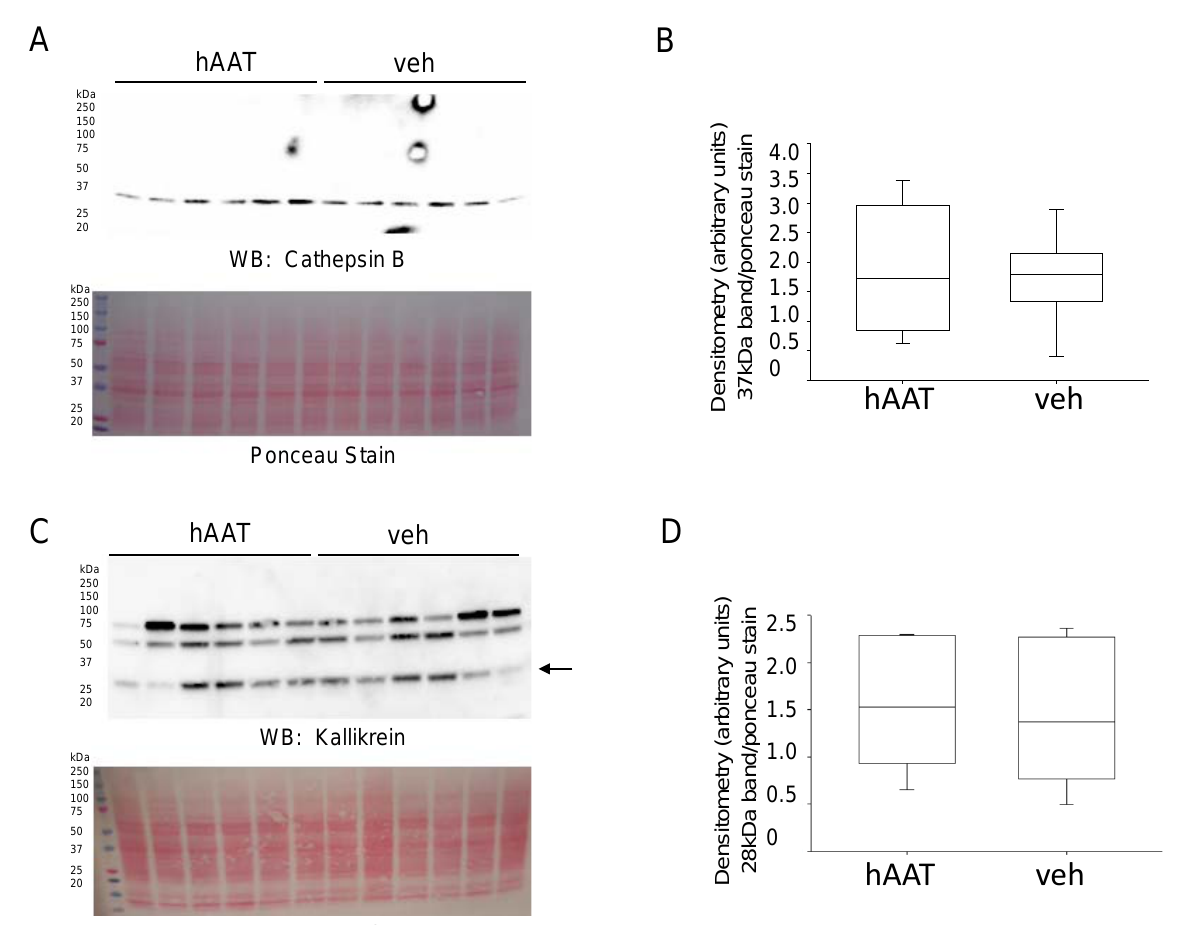
Figure 9. Western blot and densitometric analysis of cathepsin B and kidney kallikrein protein expression after hAAT or vehicle treatment. ( A ). Western blot for cathepsin B protein expression. Eighty micrograms of total protein from kidney cortex lysates from hypertensive diabetic db/db mice treated with either hAAT or vehicle. ( B ). Densitometry values were obtained using Image J for the cathepsin B band in panel A normalized to the Ponceau staining. N = 6 mice in each group. ( C ). Western blot for kallikrein protein expression. Eighty micrograms of total protein from kidney cortex lysates from hypertensive diabetic db/db mice treated with either hAAT or vehicle. ( D ). Densitometry values were obtained using Image J for the kallikrein band in panel C normalized to the Ponceau staining. N = 6 mice in each group. Table 2. Cathepsin S, Cathepsin B, and calpain protease activity in the plasma of db/db mice treated with hAAT or vehicle. Data is presented as mean ± SEM. AAT n = 6, VEH n = 6. MEAN ± SEM RELATIVE STUDENT’S T-TEST PROTEASE GROUPS FLUORESCENCE UNITS (RFU)